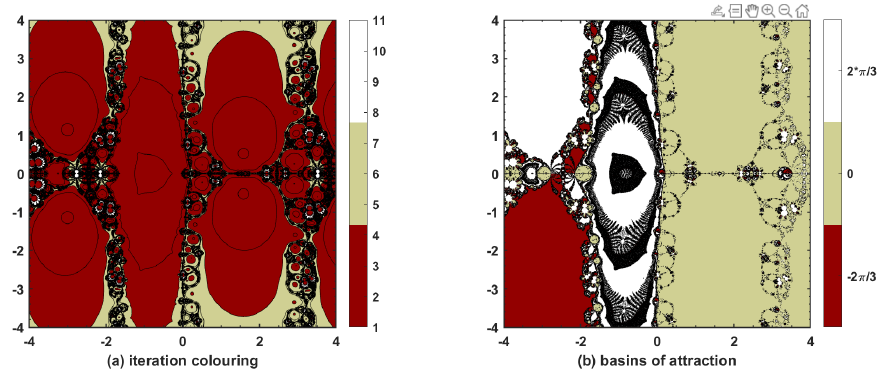
Figure 5. The polynomiographs by the proposed method PM 10 for P 3 ( z ) .